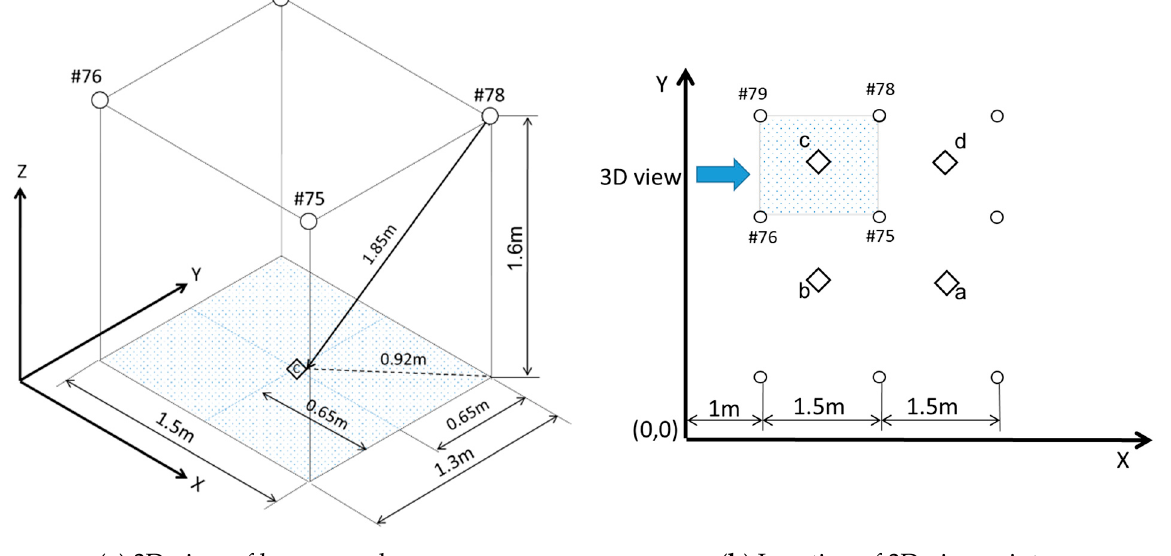
Figure 10. Geometric dimension—3D view.